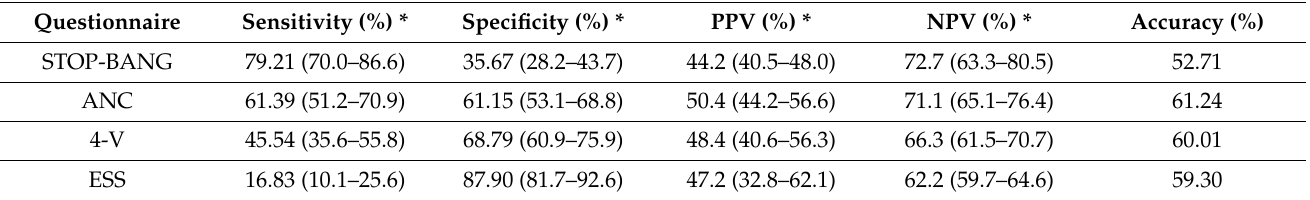
Table 5. The sensitivity, specificity, and positive and negative predictive values of the questionnaires in the prediction of moderate-to-severe obstructive sleep apnea in the study